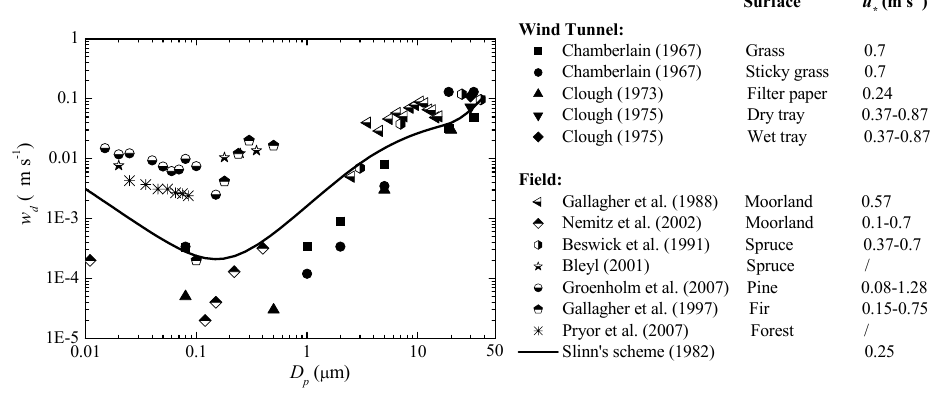
studies, measurements of dust flux and/or concentration